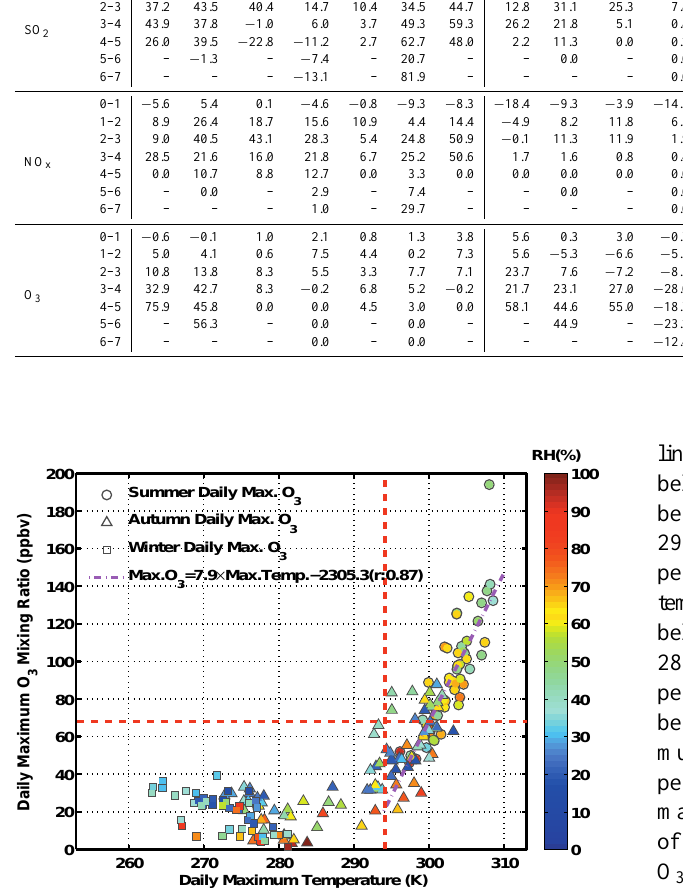
Fig. 9. Dependence of daily maximum ozone concentrations on daily maximum temperature and current RH (RH at the occurrence time of the ozone peak). Round dots stand for summer time data, triangles for fall data and squares for winter data; colours show cur- rent relative humidity. The horizontal red dashed line stands for the O 3 exceedance standard defined in Sect. 2.3; the vertical red dashed line, stands for the temperature cut-off, under which there has been no ozone exceedance detected; the magenta dashed line shows a re- gression between daily maximum temperature and daily maximum ozone above the temperature cut